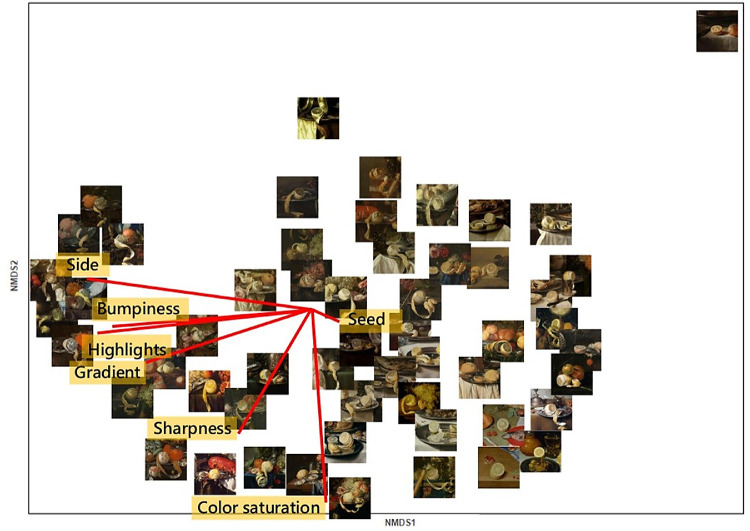
2D space of juiciness perception with the stimuli shown at the corresponding coordinates. The red lines represent the vectors of the image features fitted in the space. The space was rotated using Procrustes analysis for better comparison with the ordination of the stimuli in the translucency space in Figure 3.